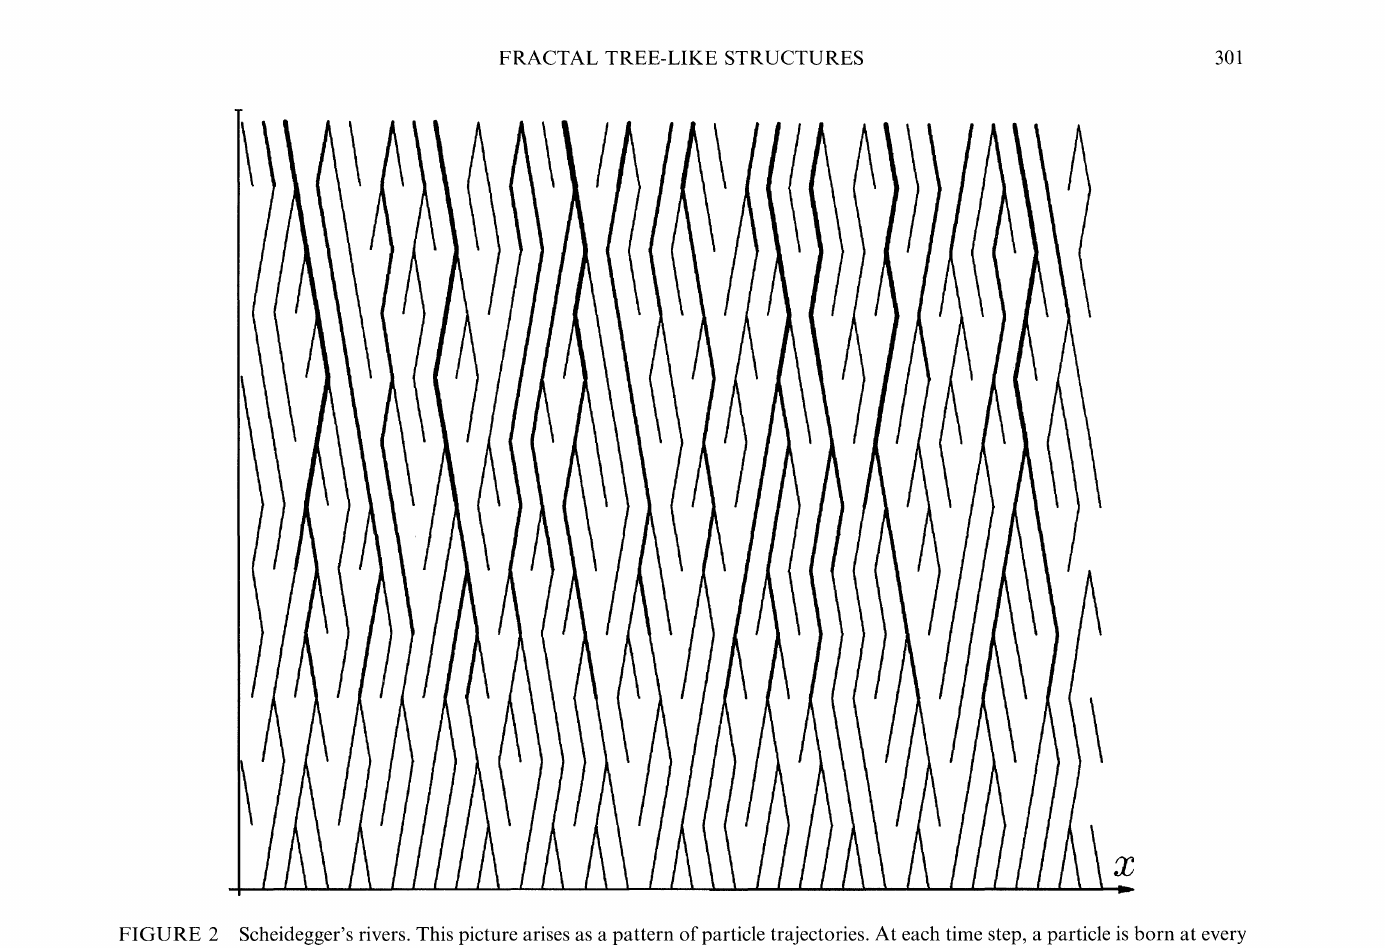
FIGURE 2 Scheidegger’s rivers. This picture arises as a pattern of particle trajectories. At each time step, a particle is born at every integer value of x; the particles move with constant velocity and random direction along the x-axis through a unit length; the colliding particles